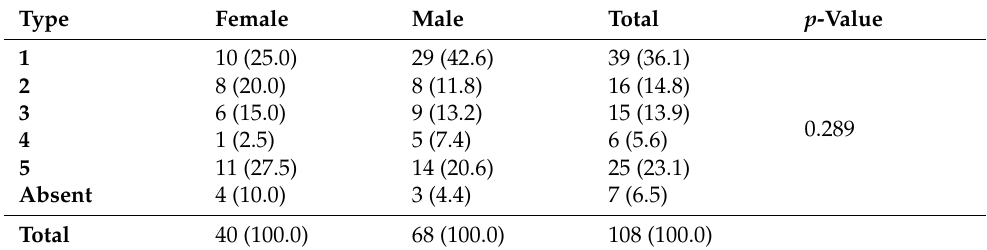
Table 1. Classification of plantaris tendon insertion type according to gender ( n = 101).